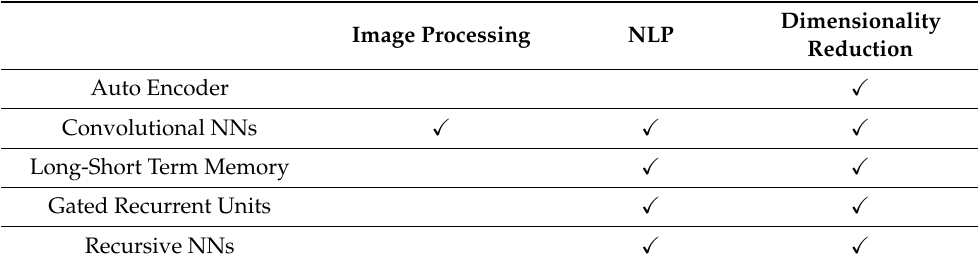
Table 1. Comparison of DNN usage. Image Processing NLP